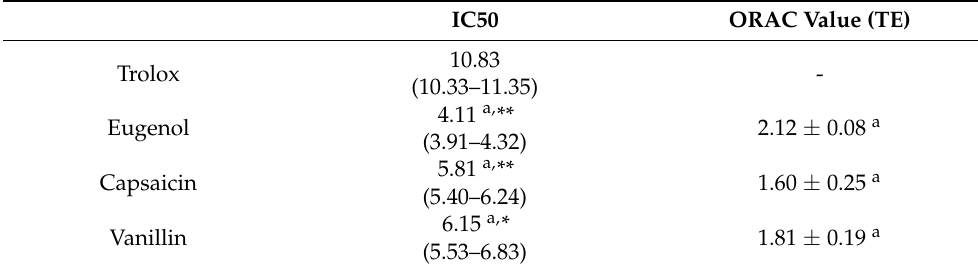
Table 5. Oxygen radical absorbing capacity (ORAC) assay results. IC50 values ( µ M) with a 95% con- fidence range (in brackets) come from the interpolation of three independent experiments. ORAC values, expressed as µ M Trolox with equivalent activity to 1 µ M phytochemical (or Trolox equiva- lents: µ M TE), are reported as the mean of three independent experiments with standard deviation. Asterisks highlight significant differences from Trolox (one-way ANOVA, Dunnett’s test: * p < 0.05, ** p < 0.001). Letters indicate significant differences among phytochemicals for each outcome for p < 0.05 (one-way ANOVA, Tukey’s multiple comparison